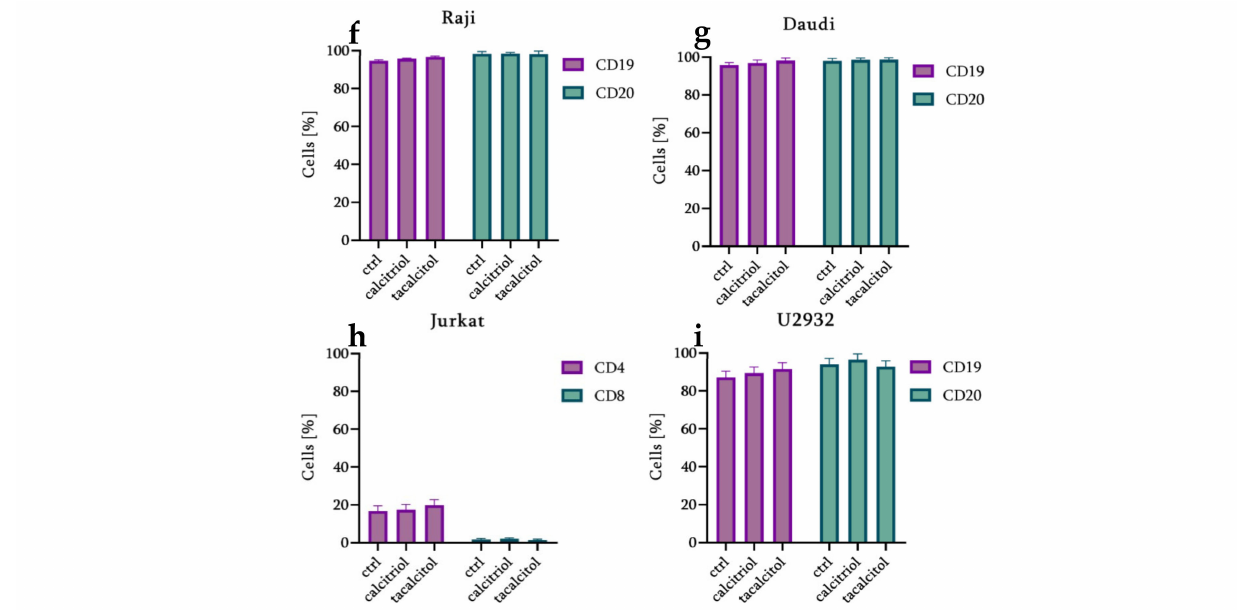
Figure 3. CD11b and CD14b antigens in MV-4-11 ( a ), Thp-1 ( b ), and HL-60 ( c ) cells sensitive to calcitriol and tacalcitol. CD34 and CD38 antigen levels in K562 ( d ) chronic myeloid leukemia and KG- 1 ( e ) acute myeloid leukemia cells. CD19 and CD20 antigens in the cells of Burkitt Raji lymphoma ( f ), Burkitt Daudi lymphoma ( g ) and diffuse large B-cell lymphoma U2932 ( i ). CD4 and CD8 antigens levels in acute leukemia cells from Jurkat T cells ( h ). Analysis of surface antigens level after 120 h of incubation with 10 nM calcitriol and tacalcitol (mean ± standard deviation). ** p < 0.05, *** p < 0.01, **** p < 0.0001 statistical significance to the